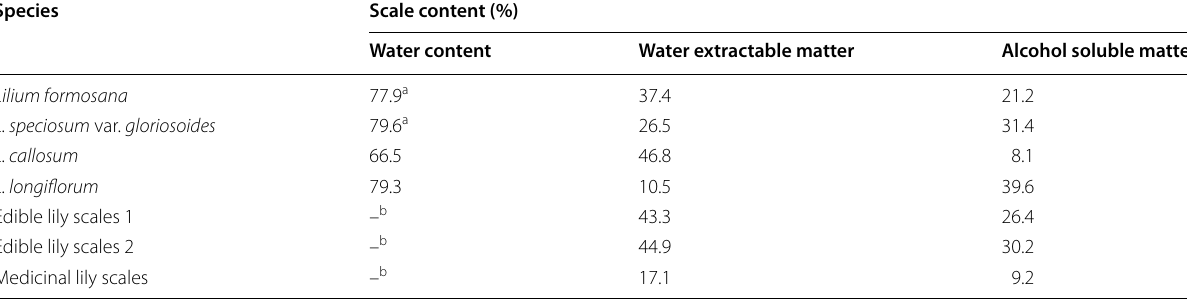
a Average of data were collected from two bulbs b The dried scales were purchased from stores